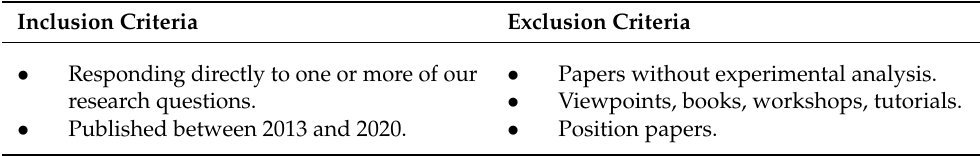
Table 7. Inclusion and exclusion